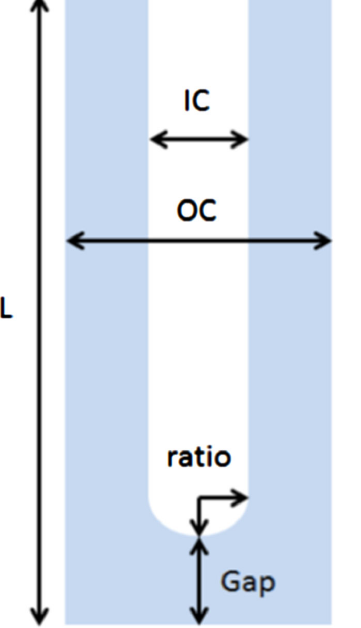
FIG. 3. The parametric simulation model of the QWR, in which the shaded area shows the rf space in the cavity. Optimization of the peak field ratio focused on the inner conductor tip ratio and gap.